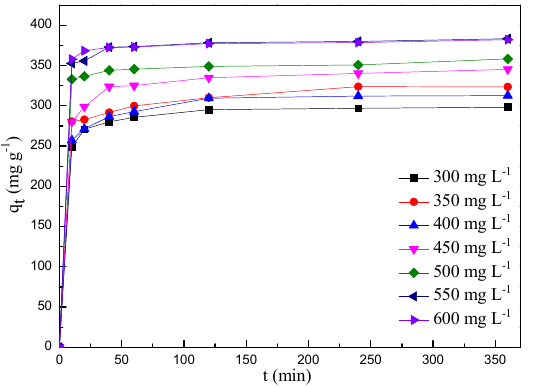
Figure 6. Adsorption capacity vs. contact time at different MB concentrations on BSNC-800-4.